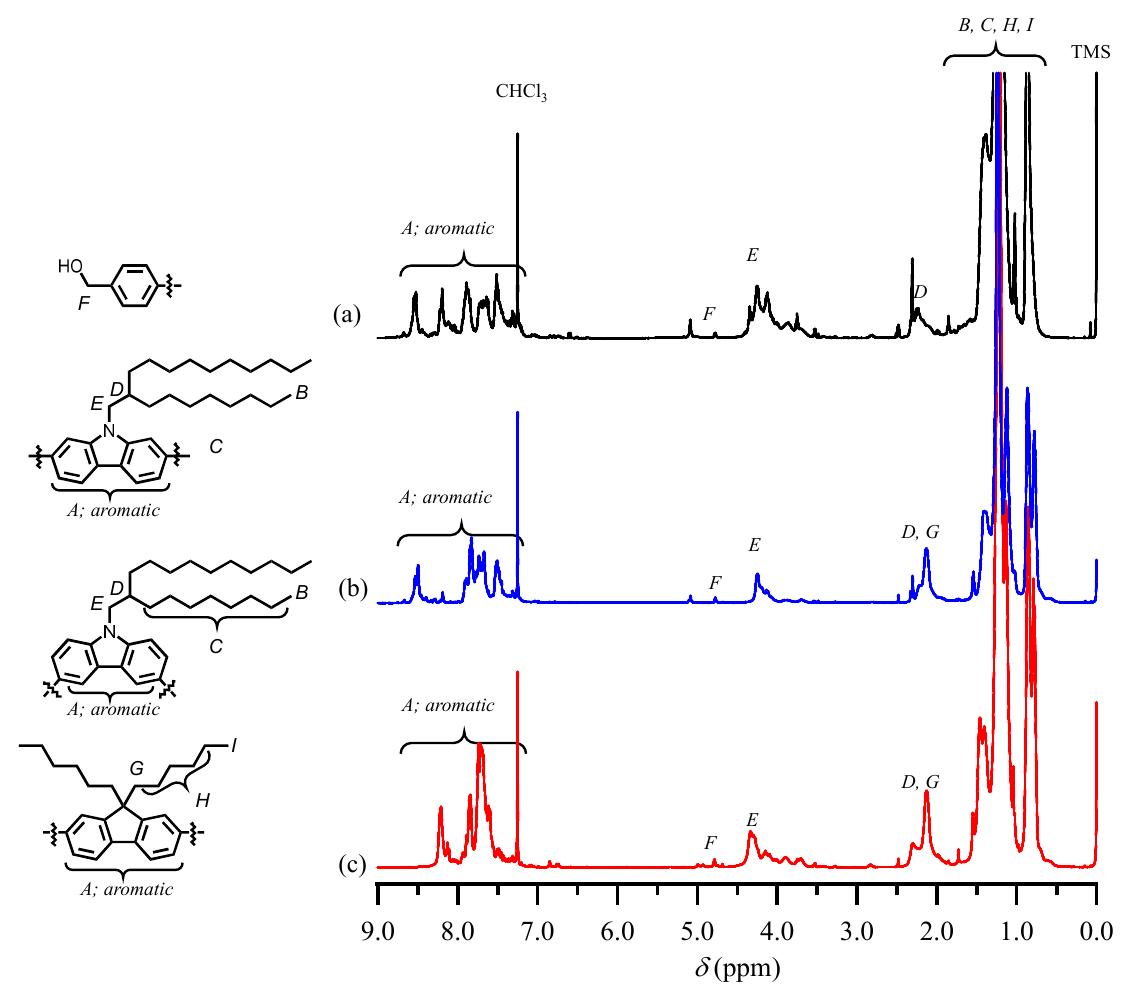
Figure 10. 1 H NMR spectra of (a) 2,7-PCz- co -3,6-PCz, ( b ) PF- co -3,6-PCz, and ( c ) PF- co -2,7-PCz (400 MHz, CDCl 3 ).